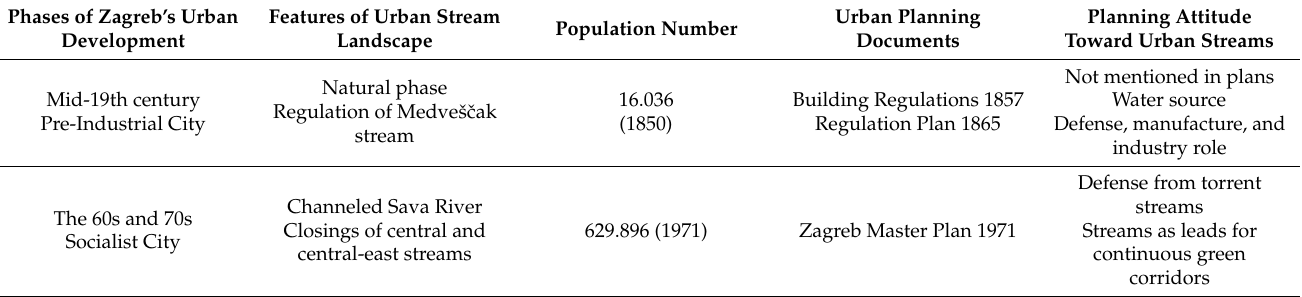
Table 3. The comparison of the genesis of Zagreb’s stream landscape, the population growth, and the development of Zagreb’s urban planning documents. Source: